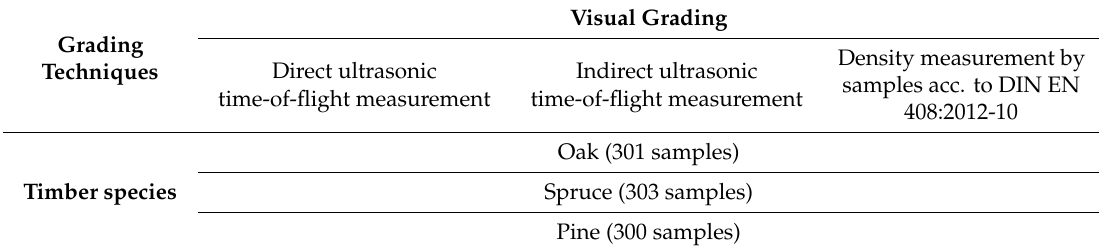
Table 1. Grading Parameters and Studied Timber